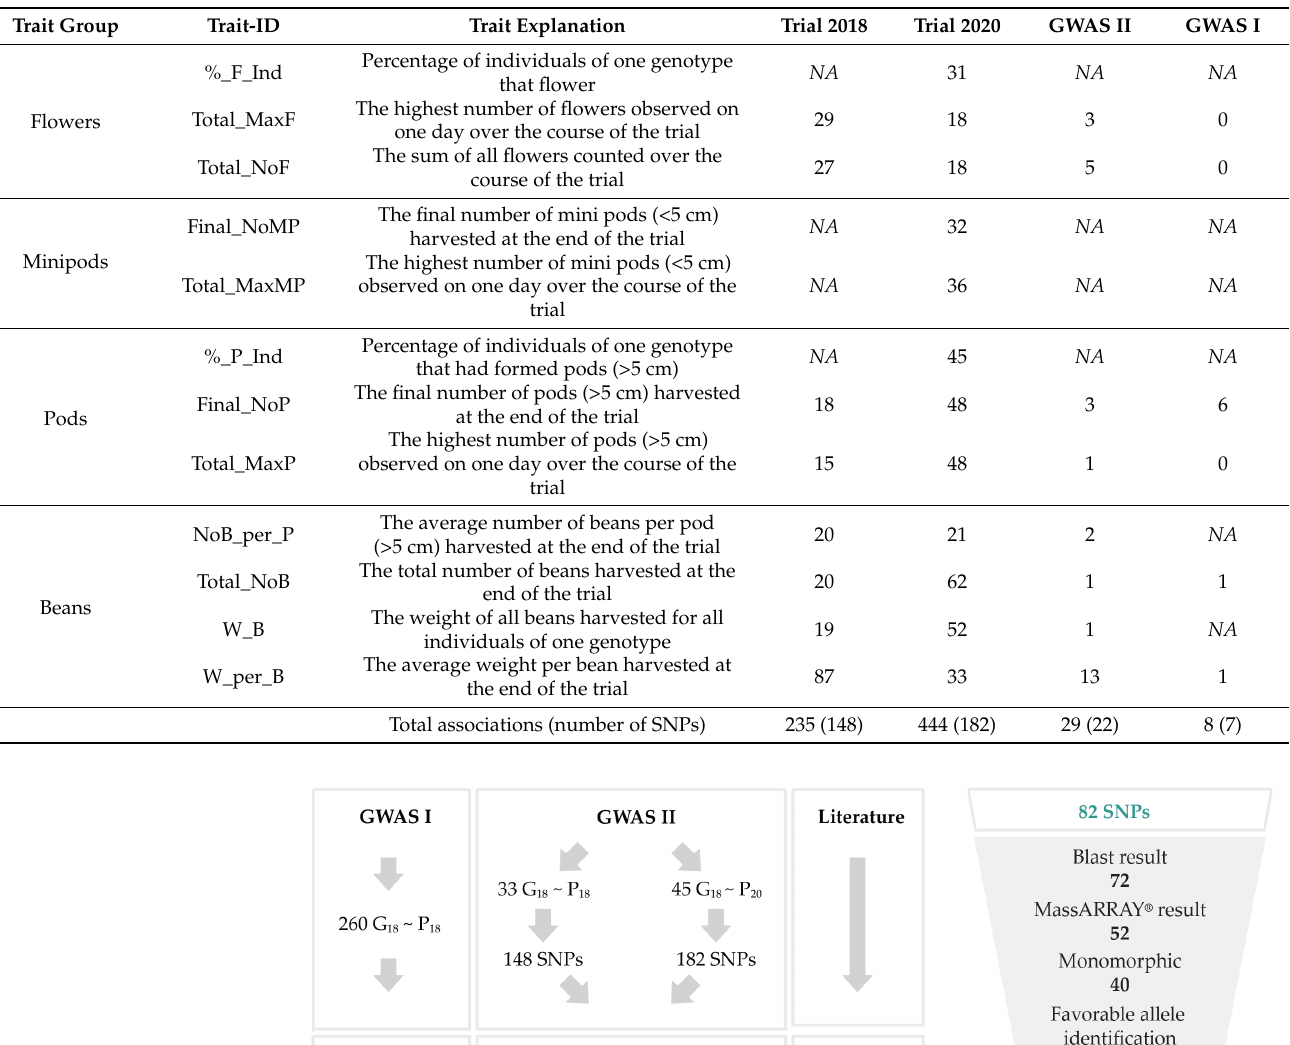
Table 1. Number of significant associations obtained by GWAS for the different phenotypic traits measured for runner bean genotypes under heat stress conditions in two different glasshouse trials in 2018 and 2020. Three traits were measured in relation to flowers, two minipod-traits, three pod-related traits, and four traits concerning beans. In trial 2018, 33 genotypes were considered for association analysis, in trial 2020 45 genotypes were considered. GWAS II reflects common associations from trial 2018 and 2020. In GWAS I 260 plants were considered for association analysis. The summarized number of associations to gene regions and the according number of associated SNPs (in brackets) are given in the last row. NA : Not applicable.